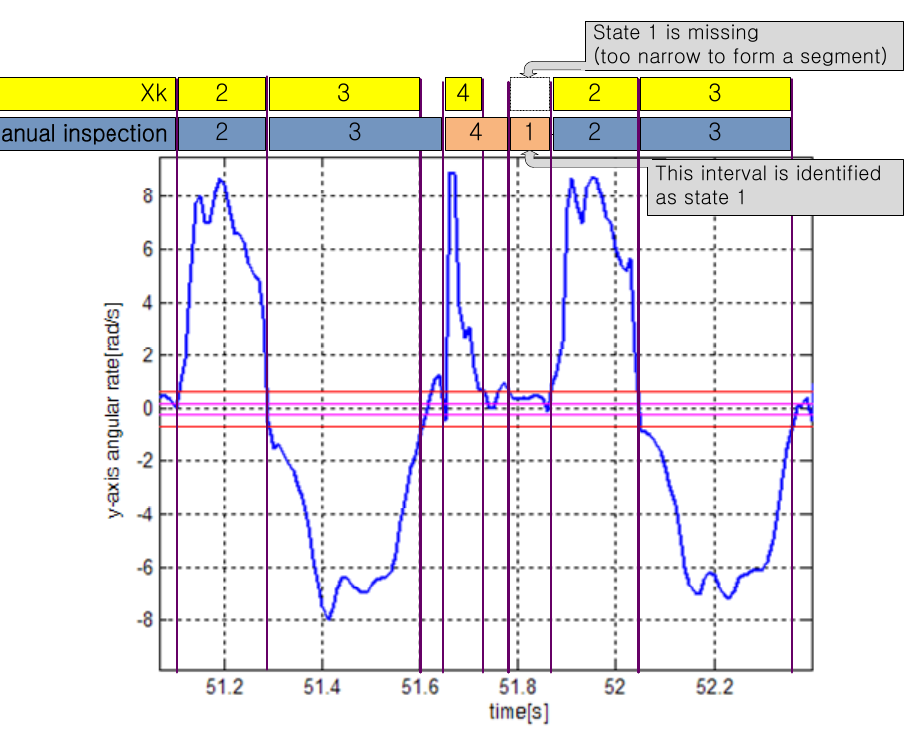
Figure 9. Case 2: state 1 is missing.